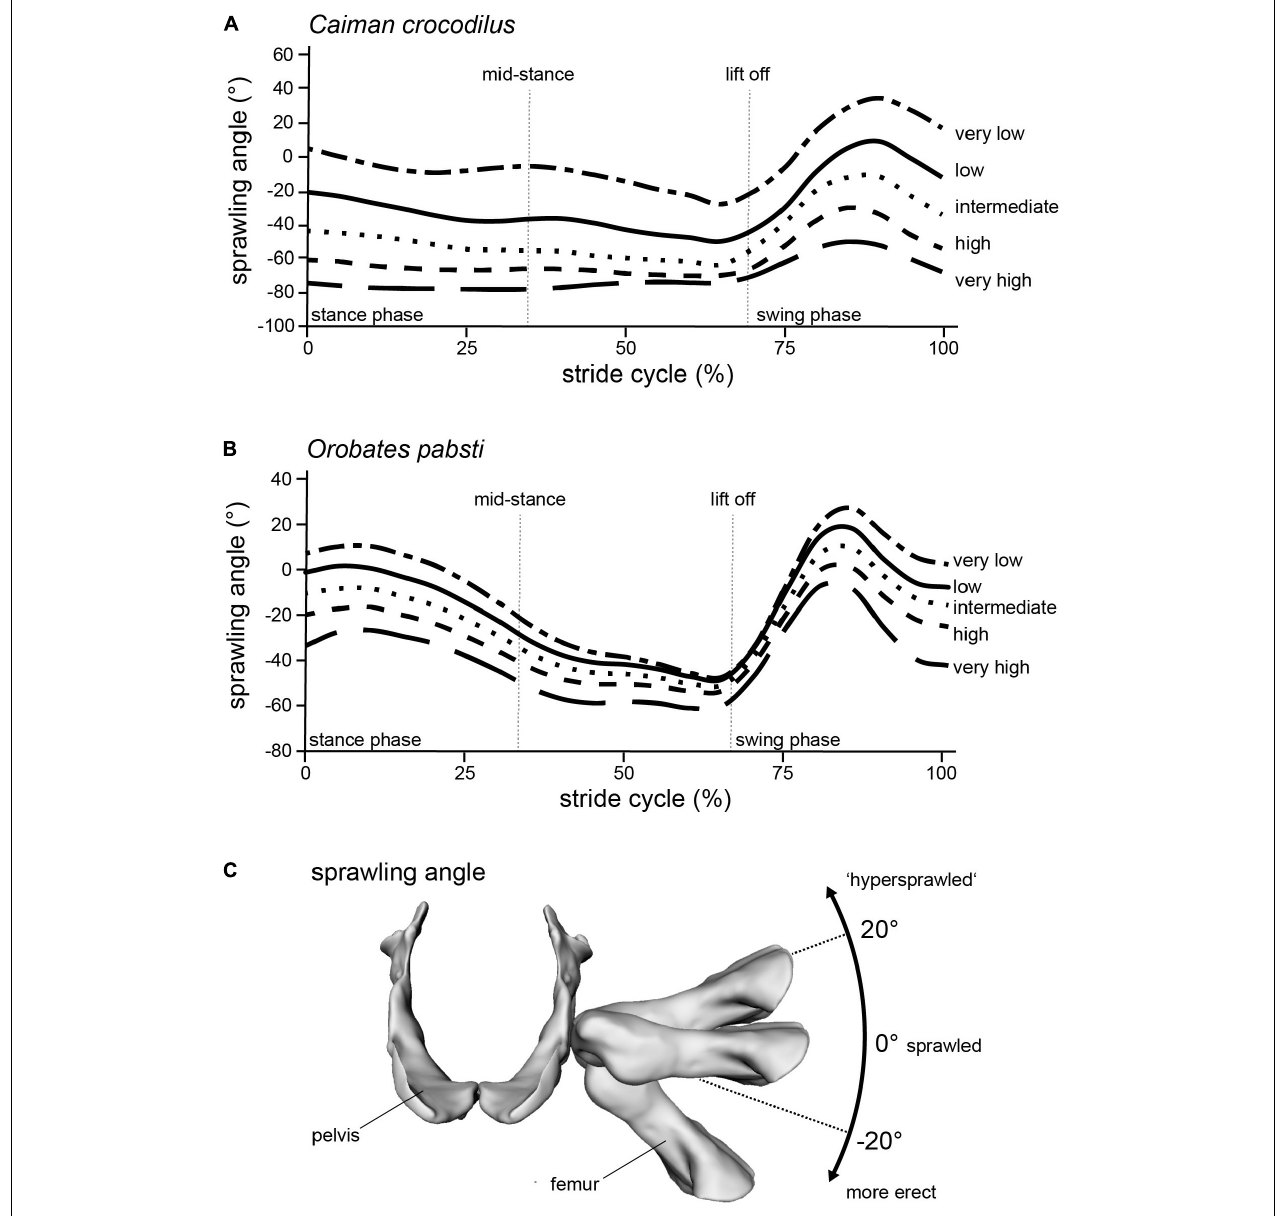
FIGURE 3 | Modeling different postures from “very low” to “very high” in (A) Caiman and (B) Orobates is reflected in the (C) sprawling angle (frontal view of the pelvis and femur of Orobates with differently ad/abducted femur). Raw data provided as Supplementary Material .